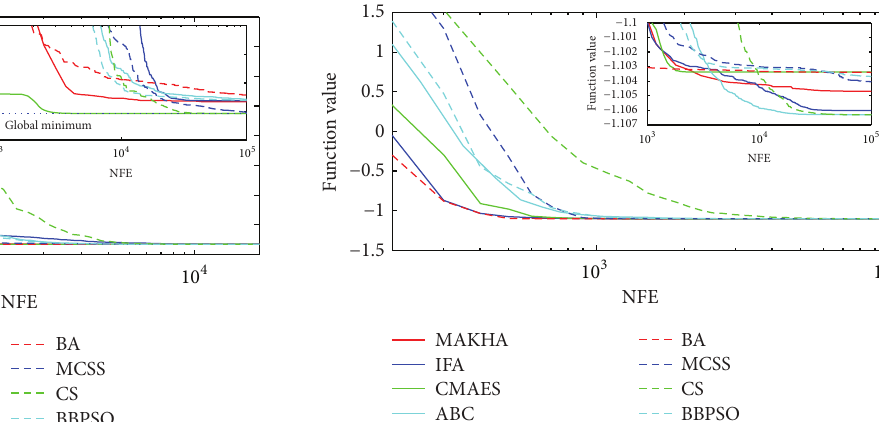
Figure 5: The evolution of the mean best value calculated via the eight metaheuristics versus NFE for problem G6.